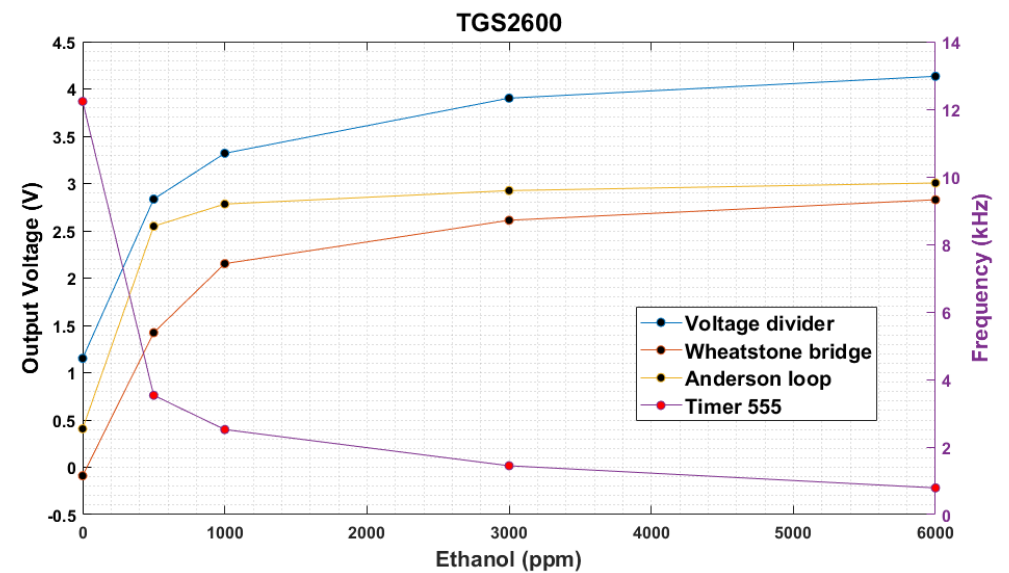
Figure 12. Values measured for all designs using the TGS2600 with different dissolutions.